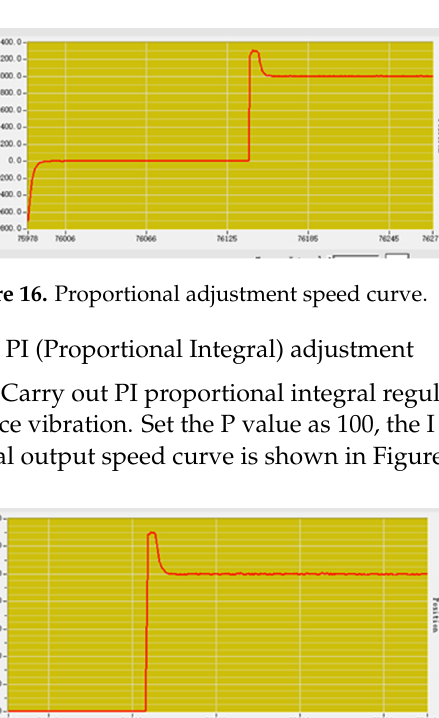
Figure 17. Proportional integration adjusts the velocity curve. 4. PID (Proportional Integral Derivative) adjustment